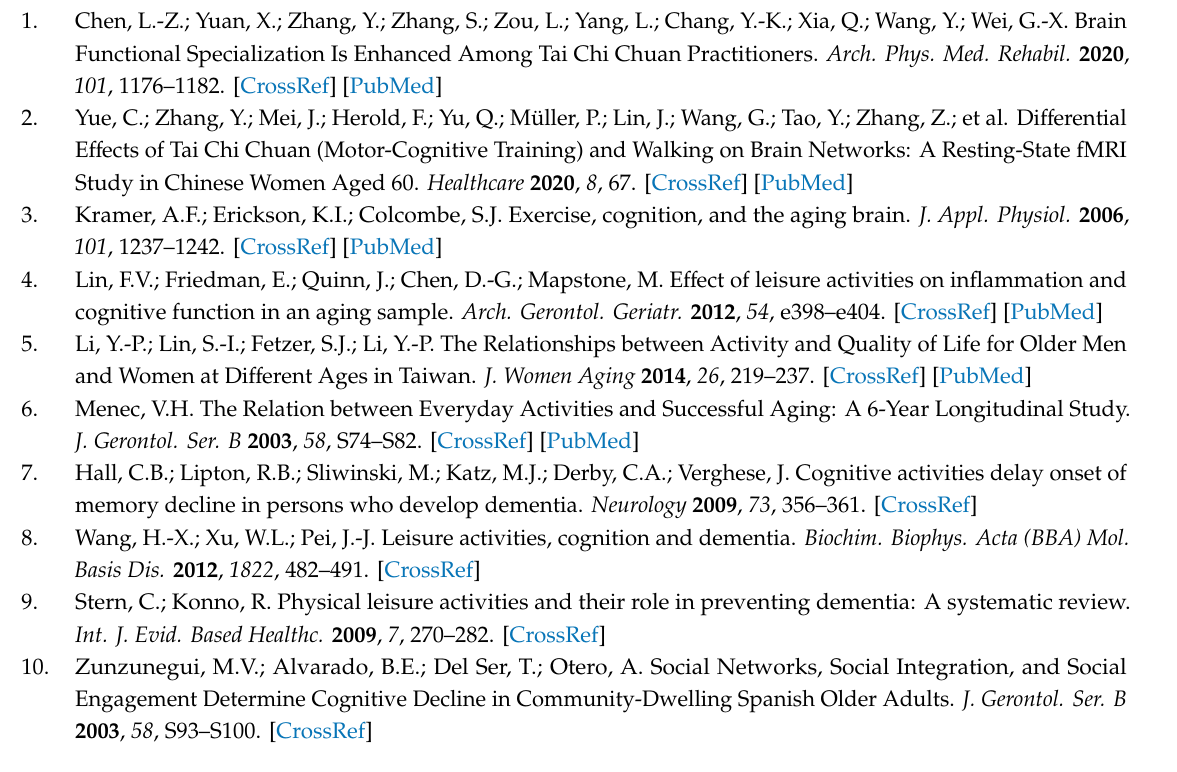
Table S1: Model fits ( R 2 ) of regression models for cognitive abilities., Table S2: Regression models of general cognition among the young-old group, Table S3: Regression models of orientation ability among the young-old group, Table S4: Regression models of calculation ability among the young-old group, Table S5: Regression models of recall ability among the young-old group, Table S6: Regression models of language ability among the young-old group, Table S7: Regression models of general cognition among the old-old group, Table S8: Regression models of orientation ability among the old-old group, Table S9: Regression models of calculation ability among the old-old group, Table S10: Regression models of recall ability among the old-old group, Table S11: Regression models of language ability among the old-old group, Table S12: Regression models of general cognition among the oldest-old group, Table S13: Regression models of orientation ability among the oldest-old group, Table S14: Regression models of calculation ability among the oldest-old group, Table S15: Regression models of recall ability among the oldest-old group, Table S16: Regression models of language ability among the oldest-old group, Figure S1: Information criteria for 1–8 class